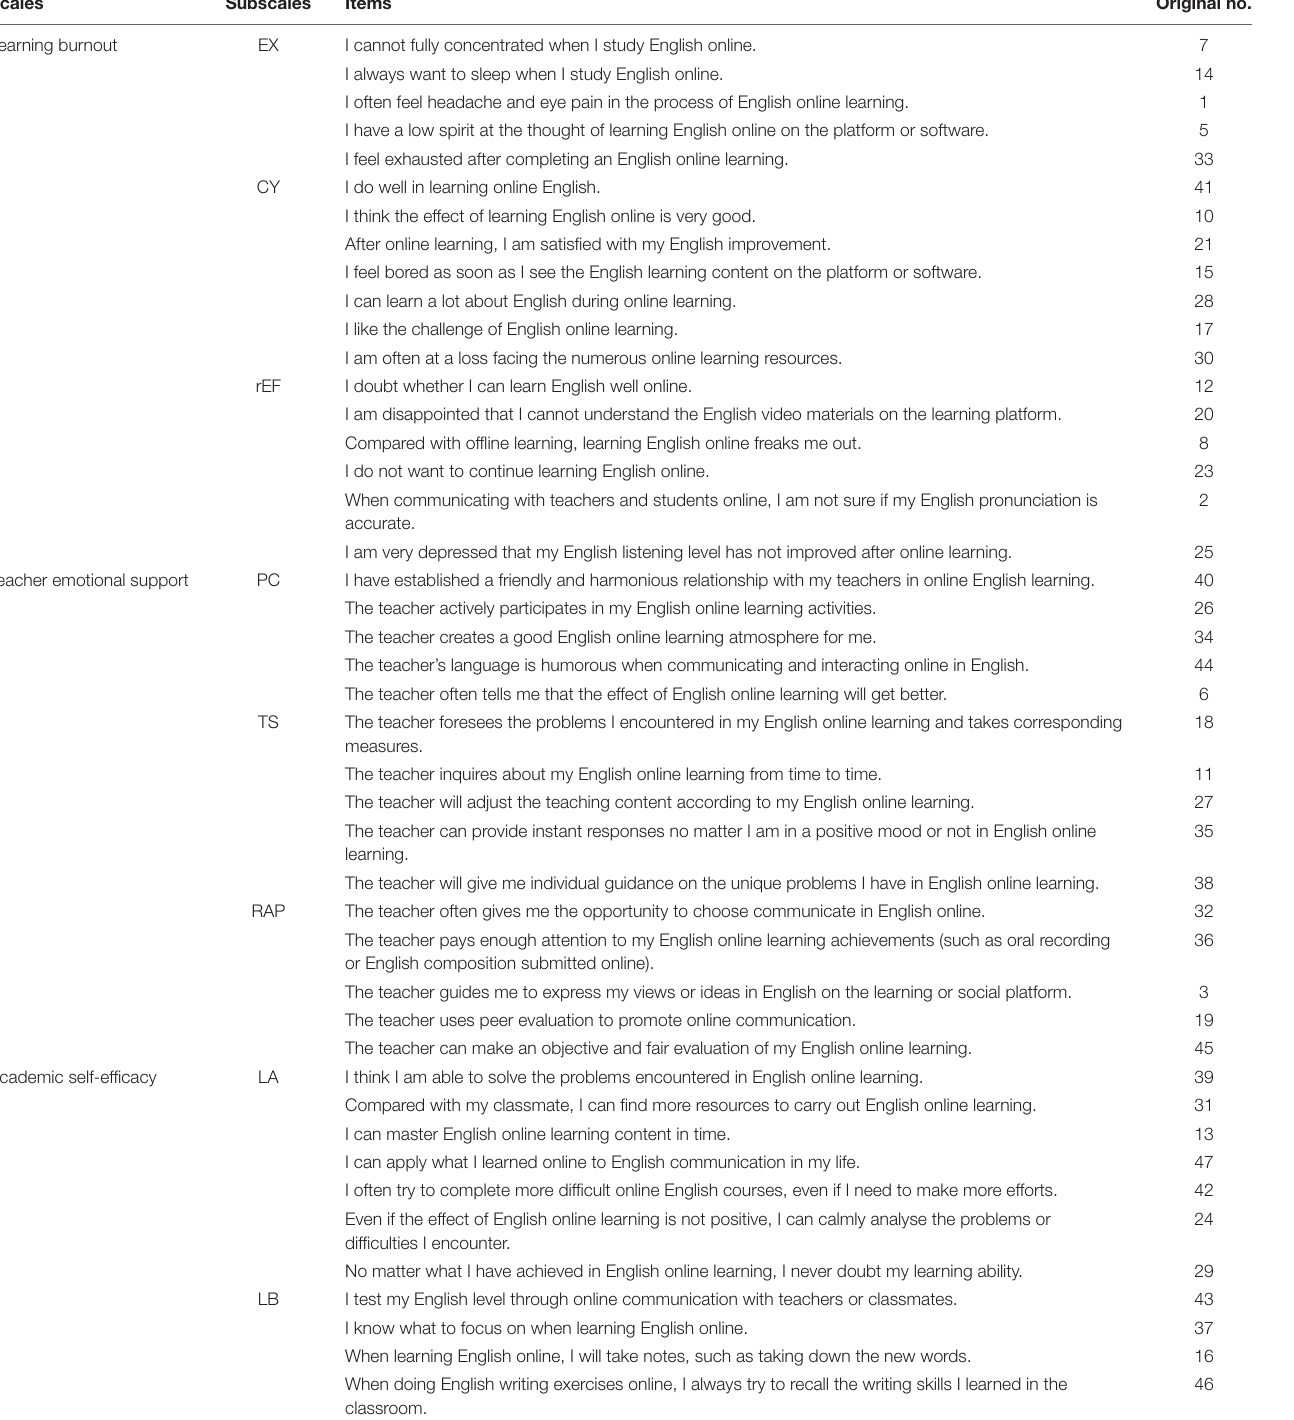
TABLE A1 | Chinese university student’s English online learning burnout scale. Scales Subscales Items Original no. Learning